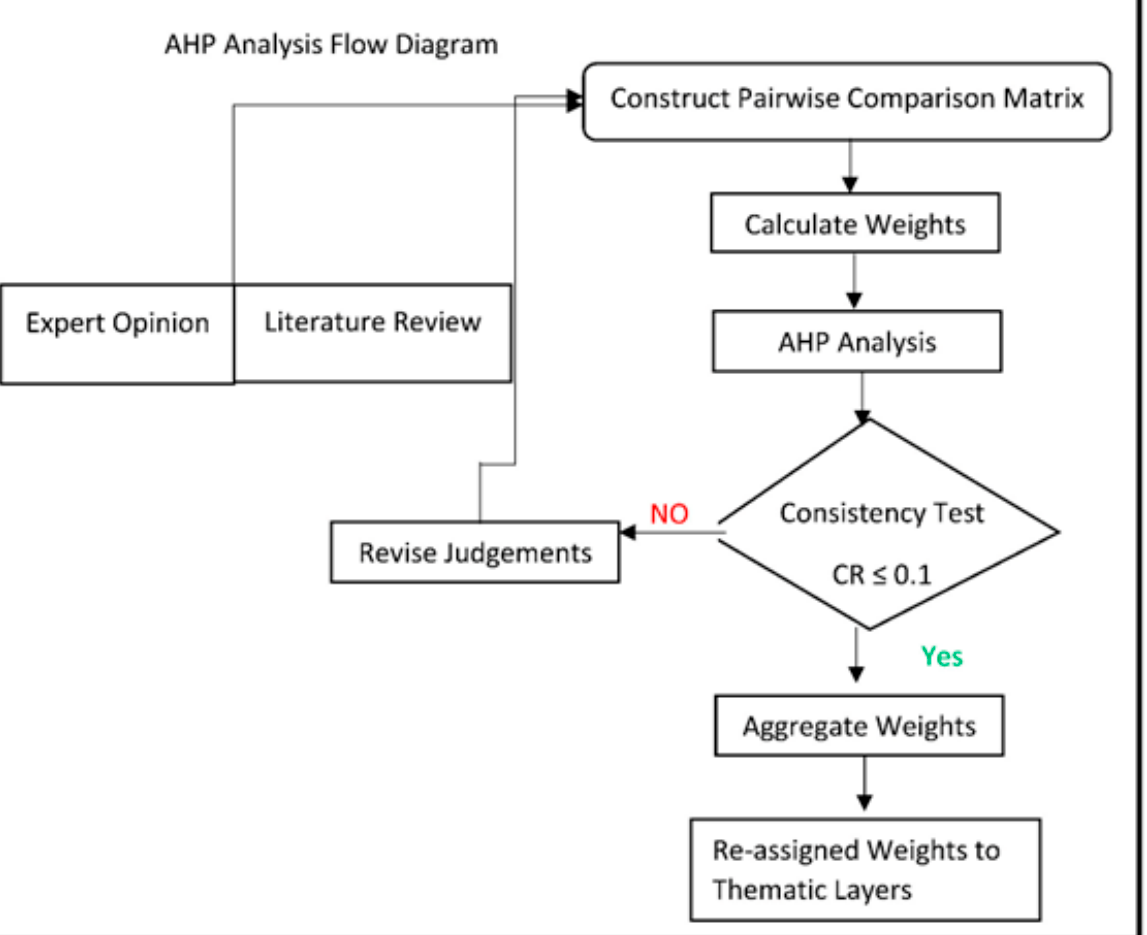
Figure 5. AHP flow chart for the consistency ratio test.